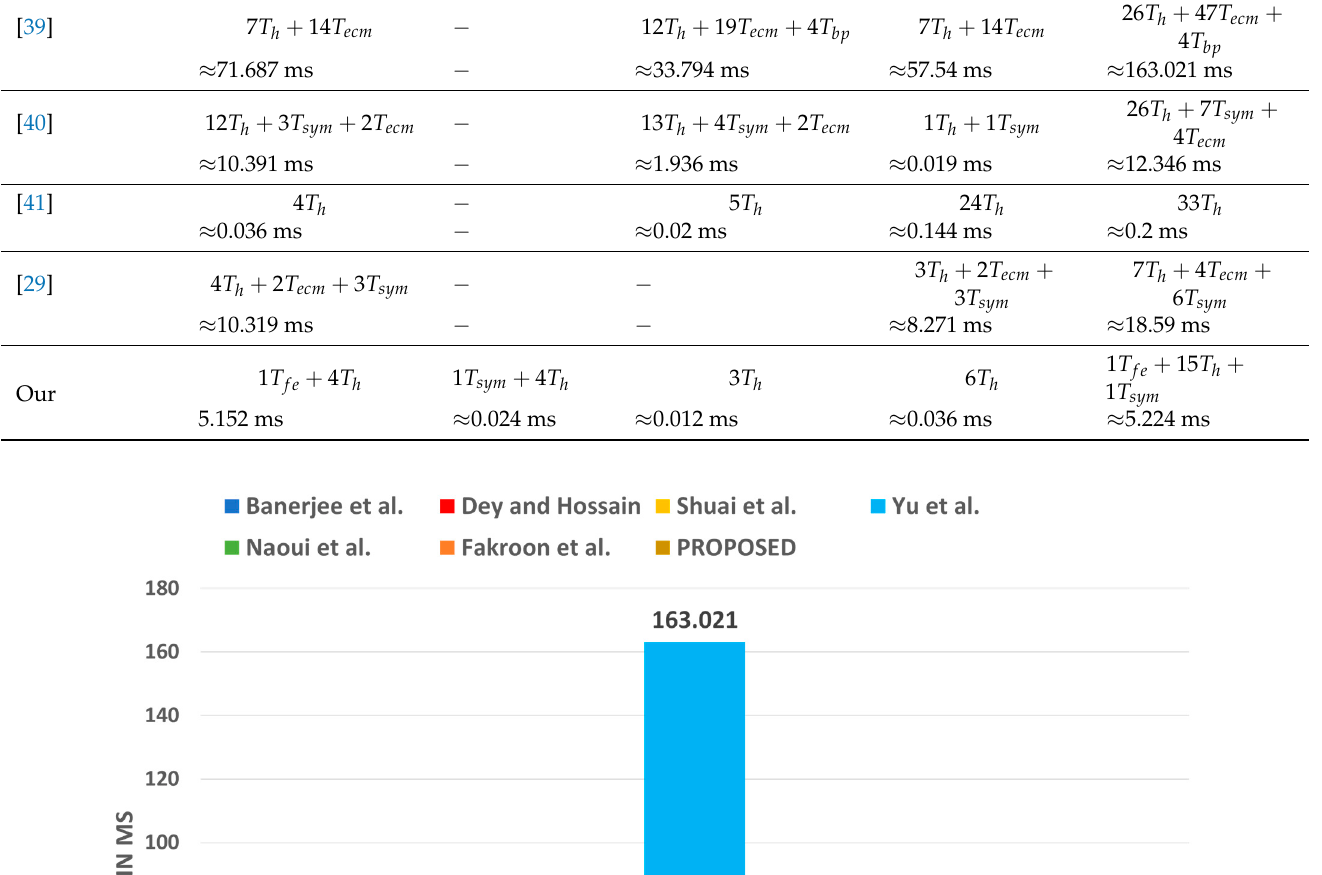
Table 9. Computation cost comparison.